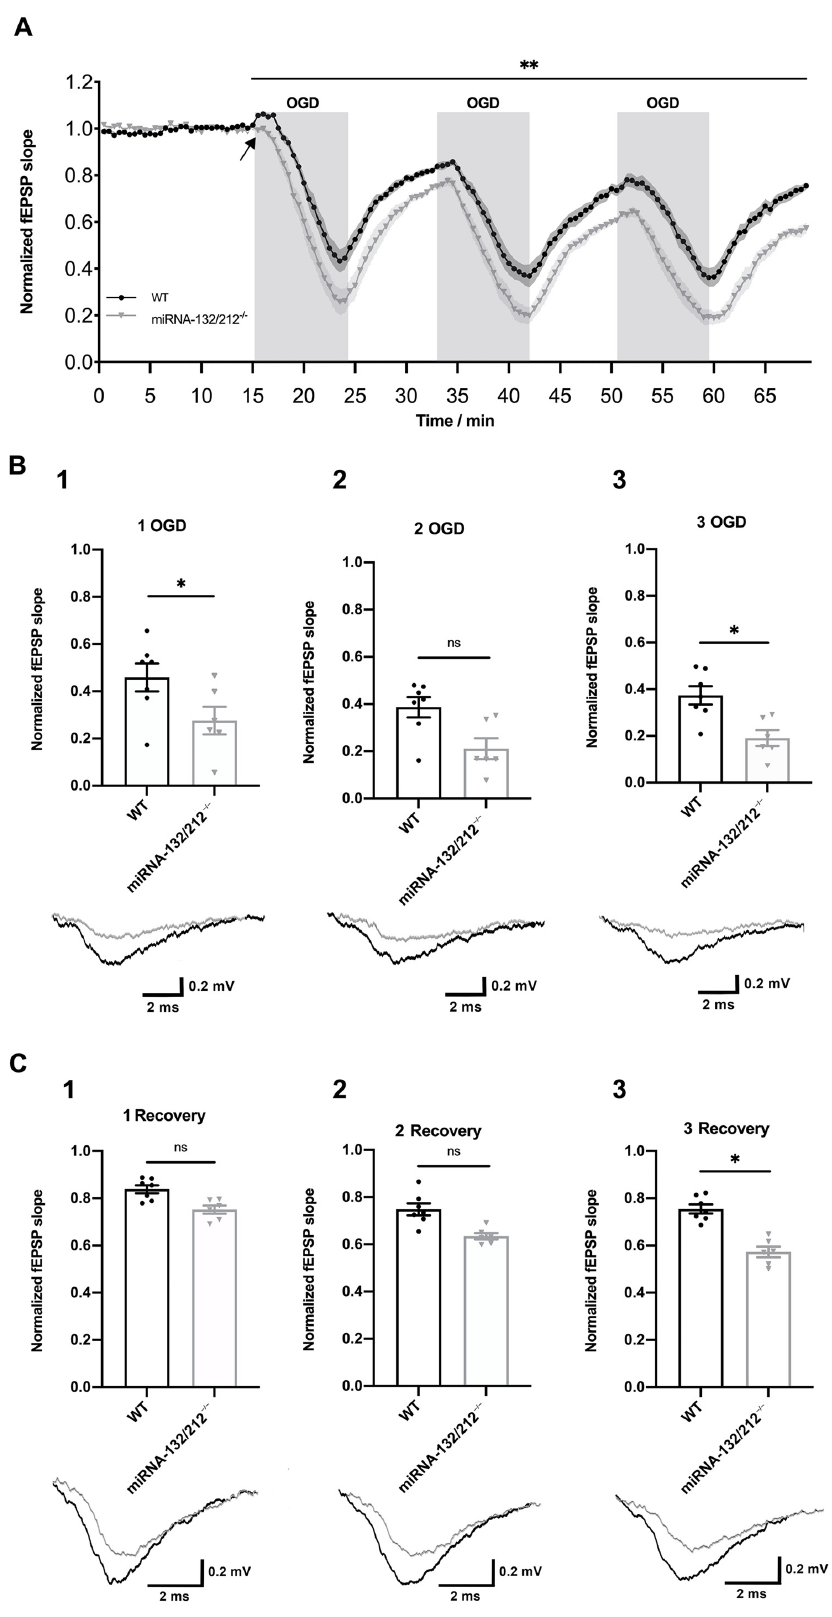
Figure 2. miRNA-132/212 gene disruption aggravated oxygen glucose deprivation (OGD) induced depression of synaptic transmission in the hippocampal dentate gyrus. ( A ) Temporal course of the fEPSPs slope changes elicited by three repeated 8 min long OGD episodes (100%N 2 , Glucose deprived aCSF), with interspersed 10 min recovery intervals (95%O 2 /5%CO 2